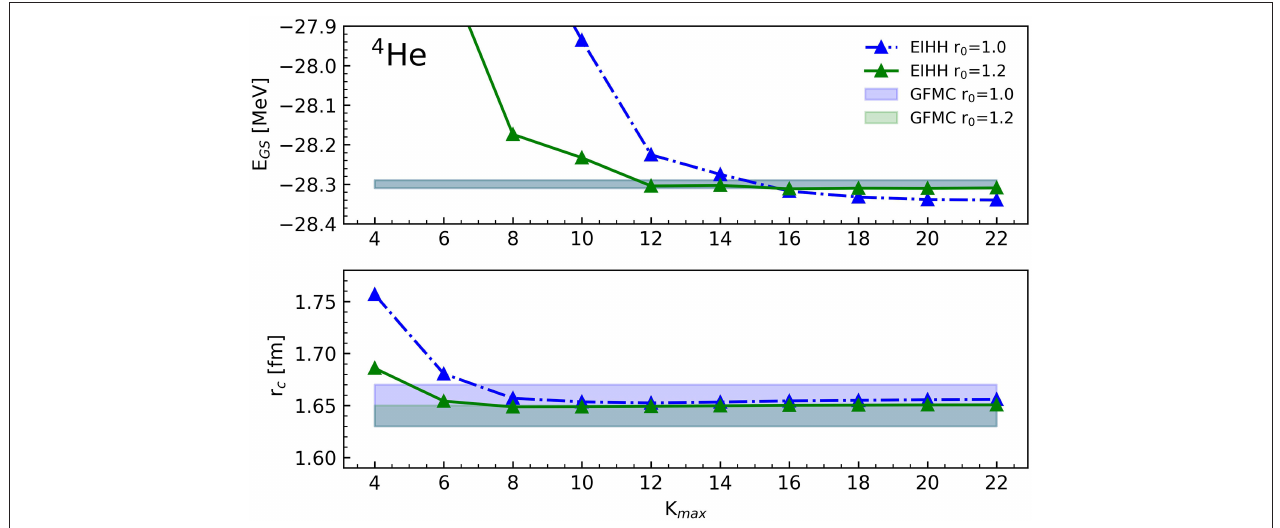
FIGURE 4 | The ground state energy and the charge radius of the nuclear 4 He system as a function of the grand-angular momentum quantum number K max . The green and blue error-bands are the GFMC results with the relative statistical uncertainty.